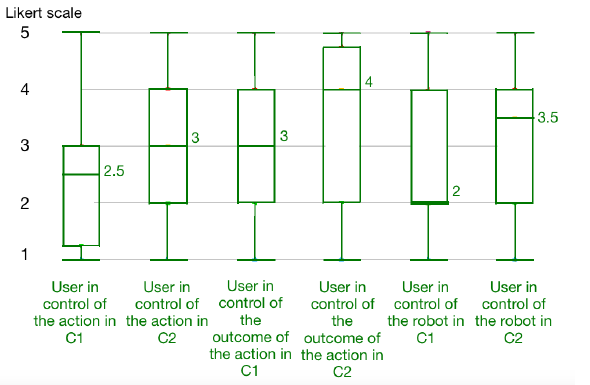
Figure 16: Task 4: carrying biscuits.